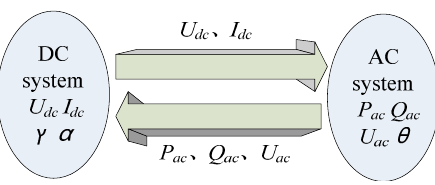
Figure 2. The alternating solution process diagram of the AC/DC hybrid distribution network (DN).